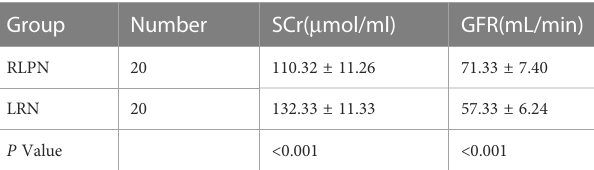
TABLE 5 SCR and GFR comparison between RLPN group and LRN